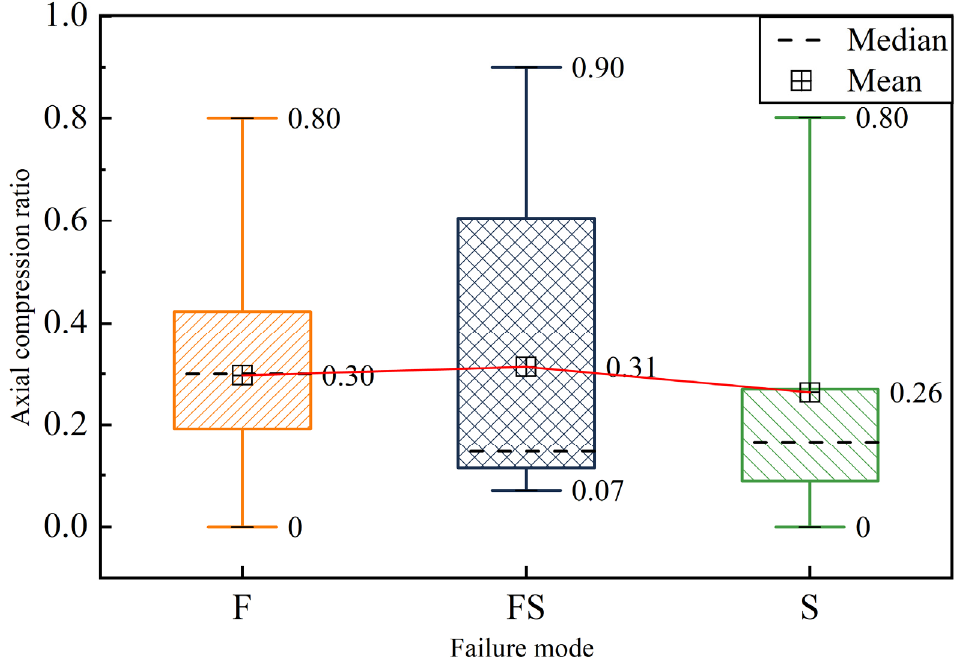
Figure 4. Distribution of axial compression ratio in different failure modes.